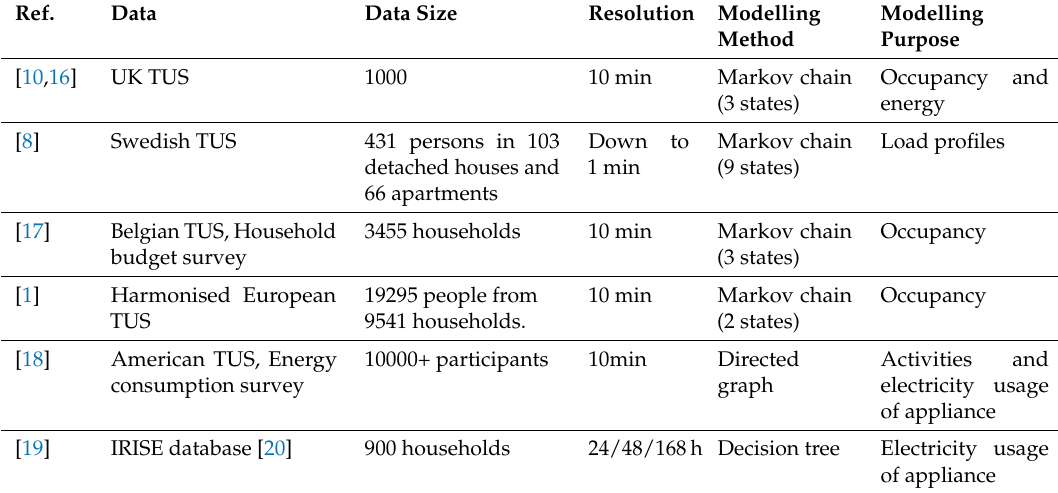
Table 1. The approaches of activity Modelling using Time Use Survey (TUS) data. Ref.